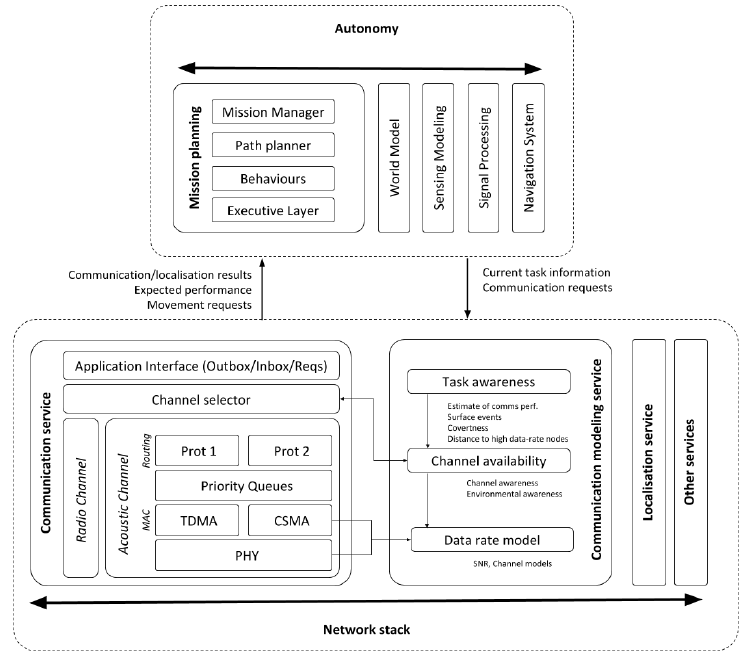
Figure 7. Interplay between autonomy and communications. Both systems make services